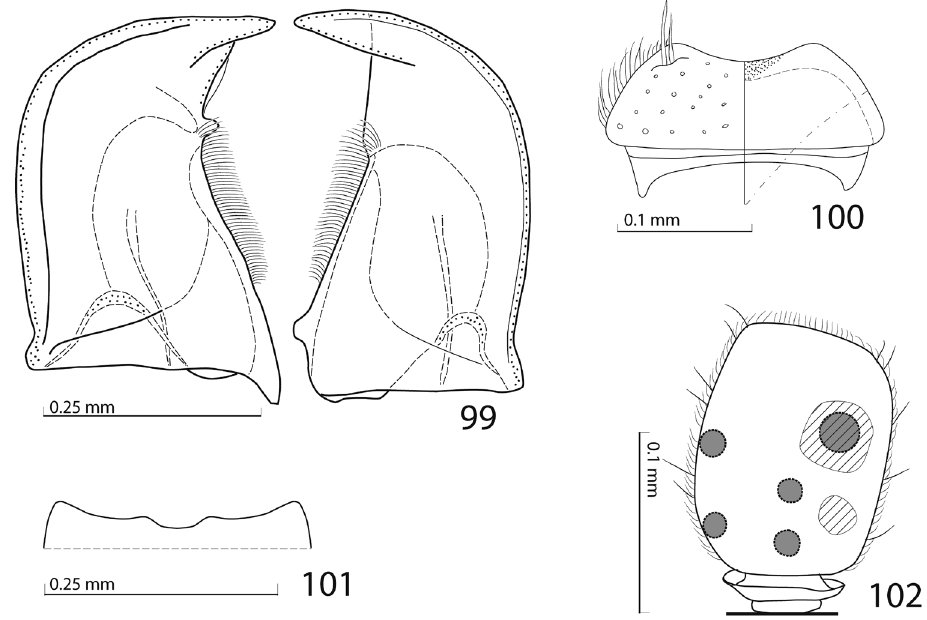
half depicting dorsal view and right half depicting epipharynx 101 anterior margin of mentum, ventral view 102 antennal club, ventral view showing sensory structures of the